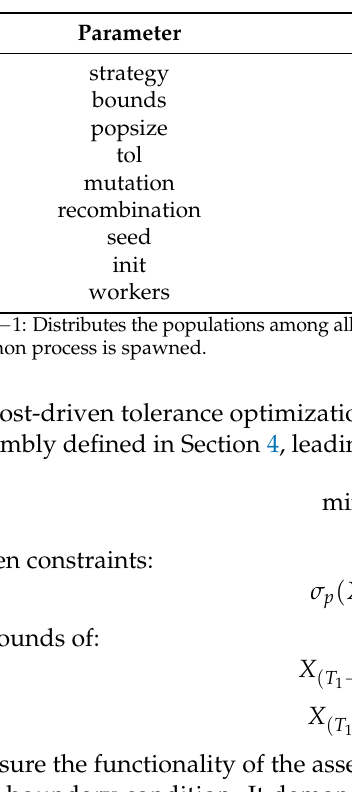
Table 5. Settings for the differential evolutionary